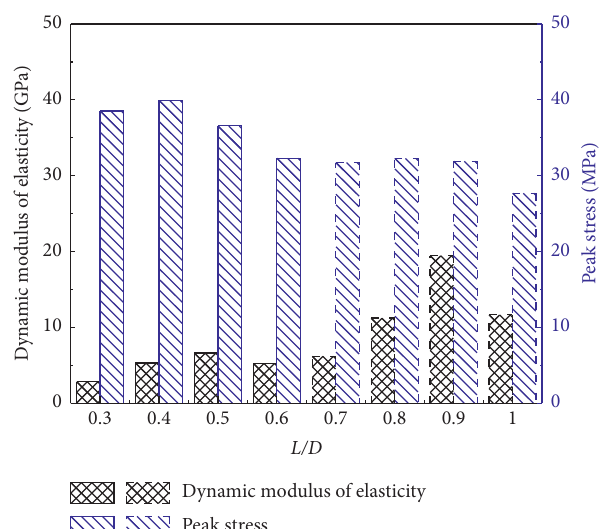
Figure 10: Dynamic modulus of elasticity and the peak stress of coal samples with different L / D ratios.